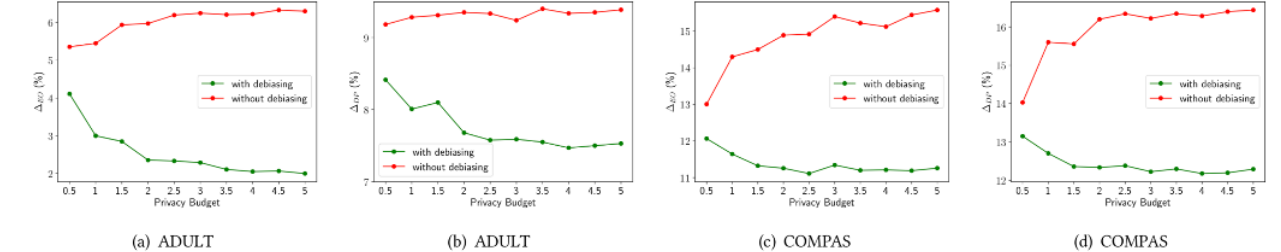
Figure 2. Assessing the impact of fairness performances under private data. ( a , b ) ADULT, ( c , d ) COMPAS [87].